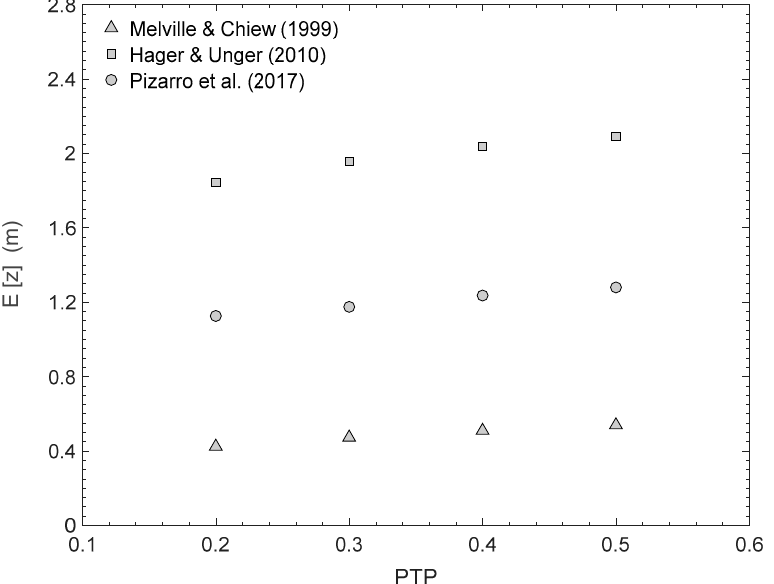
Figure 7. Expected scour depth E[ z ] (m) in function of the percental time to peak (PTP) according to the various scour models, for T = 100 years and k = 2.